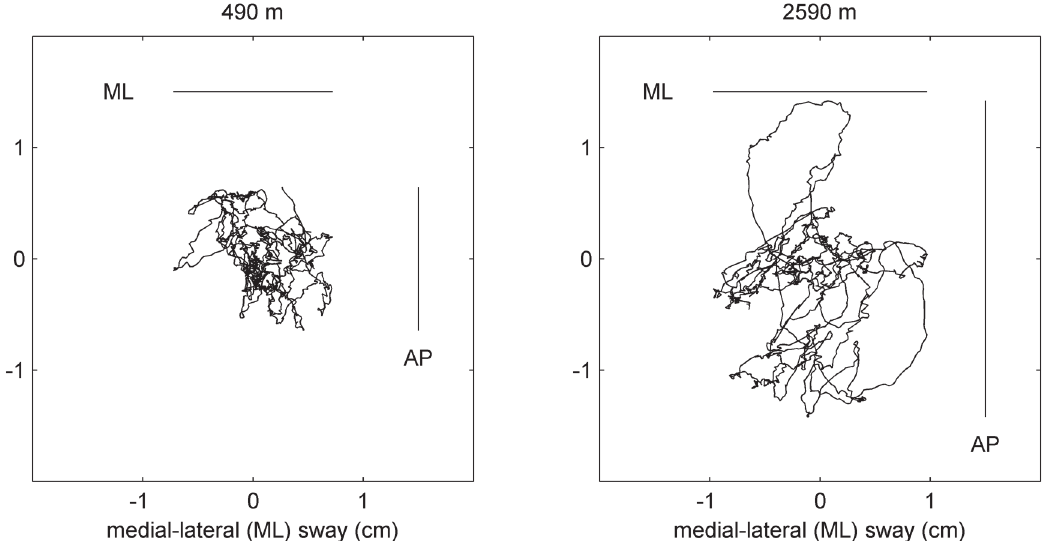
Fig 2. Center of pressure recorded in an individual during a 30 s balance board test on both legs with eyes open at 490 m and 2590 m. Center of pressure path length (COPL) = 45 and 56 cm; anterior-posterior (AP) sway amplitude = 1.3 and 2.8 cm; medial-lateral (ML) sway amplitude = 1.4 and 1.9